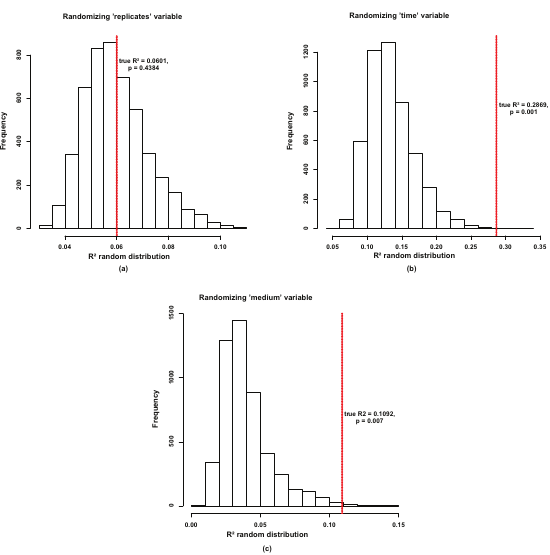
Figure A1. Beta diversity. A modified version of PermanovaG was used to carry out permutational multivariate analysis of variance using multiple distance matrices. The distance matrices [24 × 24] were previously calculated based on the generalized UniFrac distance [53], weighted UniFrac and unweighted UniFrac [107] distance. The significance for the test was assessed by 5000 permutations. ( a ) shows no significant effect between the replicates ( p -value of 0.4384). ( b ) shows a significant effect for the time variable ( p -value of 0.001). ( c ) shows also shows a significant effect for the medium variable ( p -value of